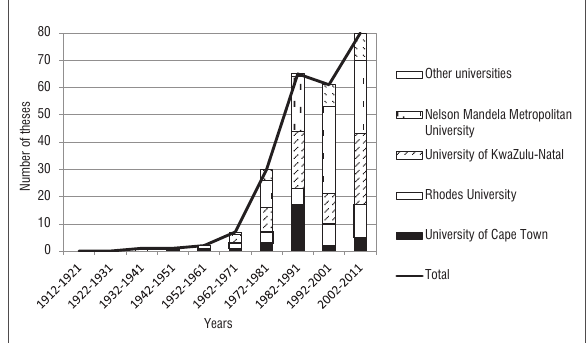
Figure 6: Decadal diagram illustrating the production of Masters and Doctoral theses by students conducting South African estuarine studies at various universities.